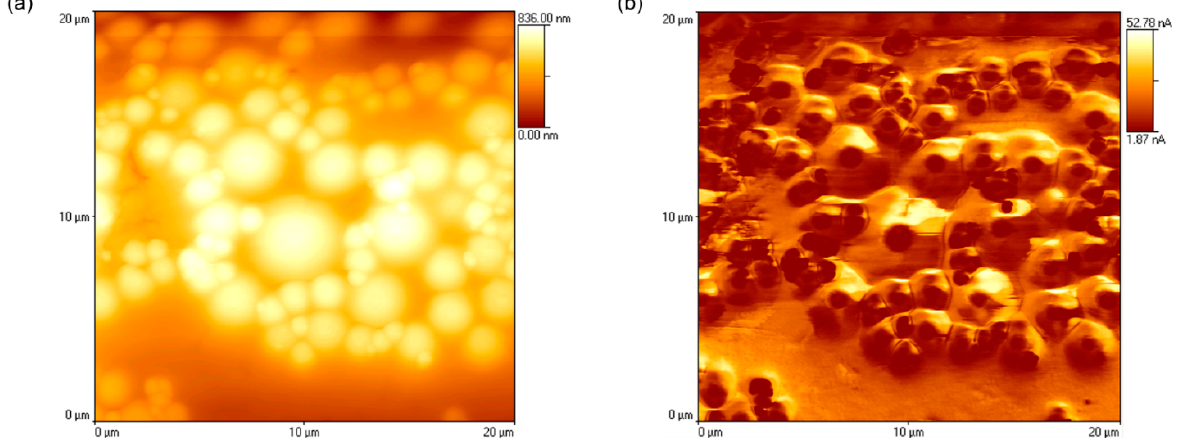
Figure 4. AFM scans of the topography ( a ) and lateral force ( b ) of the hydrophilized PDMS imme- diately after UV radiation. ately after UV